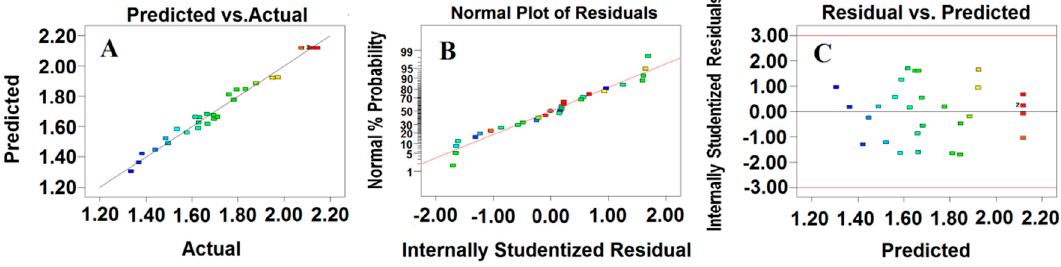
Figure 3. Predicted total flavonoid content versus experimental total flavonoids content ( A ); normal probability plots as a function of residuals ( B ) and plots of the residuals versus the predicted response ( C ).